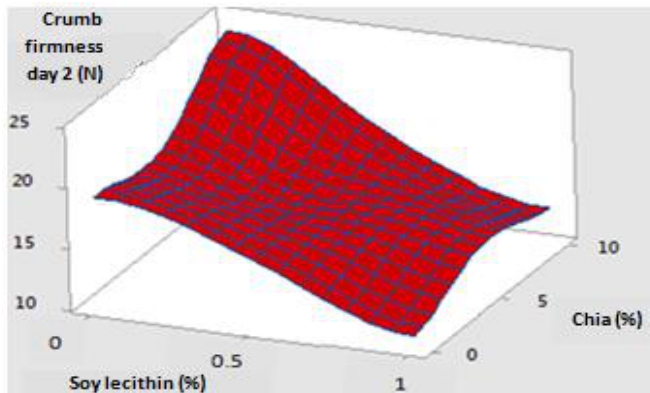
Figure 5. Response surface of crumb firmness of two days stored bread at 25 °C.